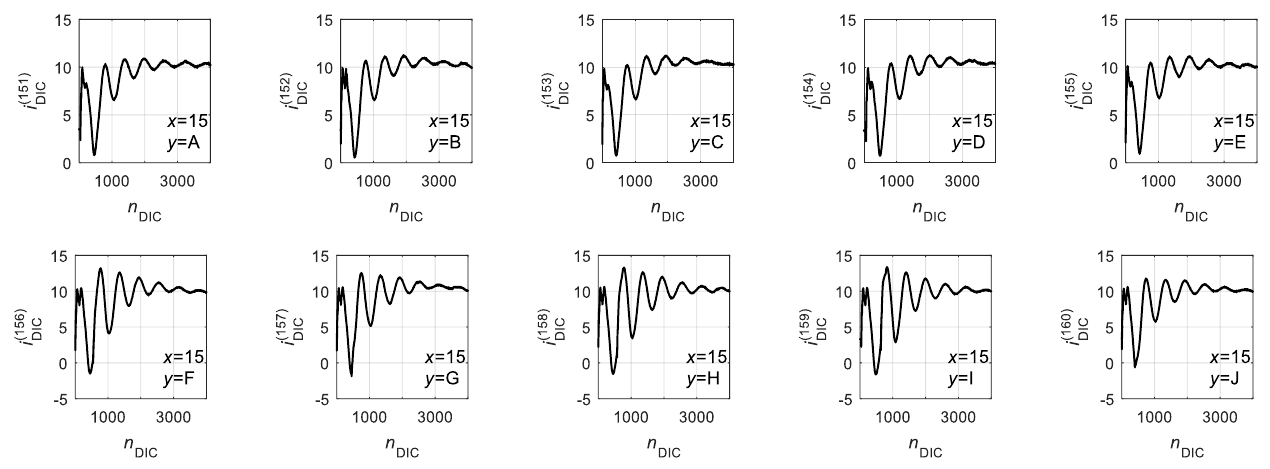
i for the dictionary elements for the category lamp with a bulb “Osram” = ( 3 ) x . Figure 22. Current vectors i DIC for the dictionary elements for the category lamp with a bulb “Osram” D I C